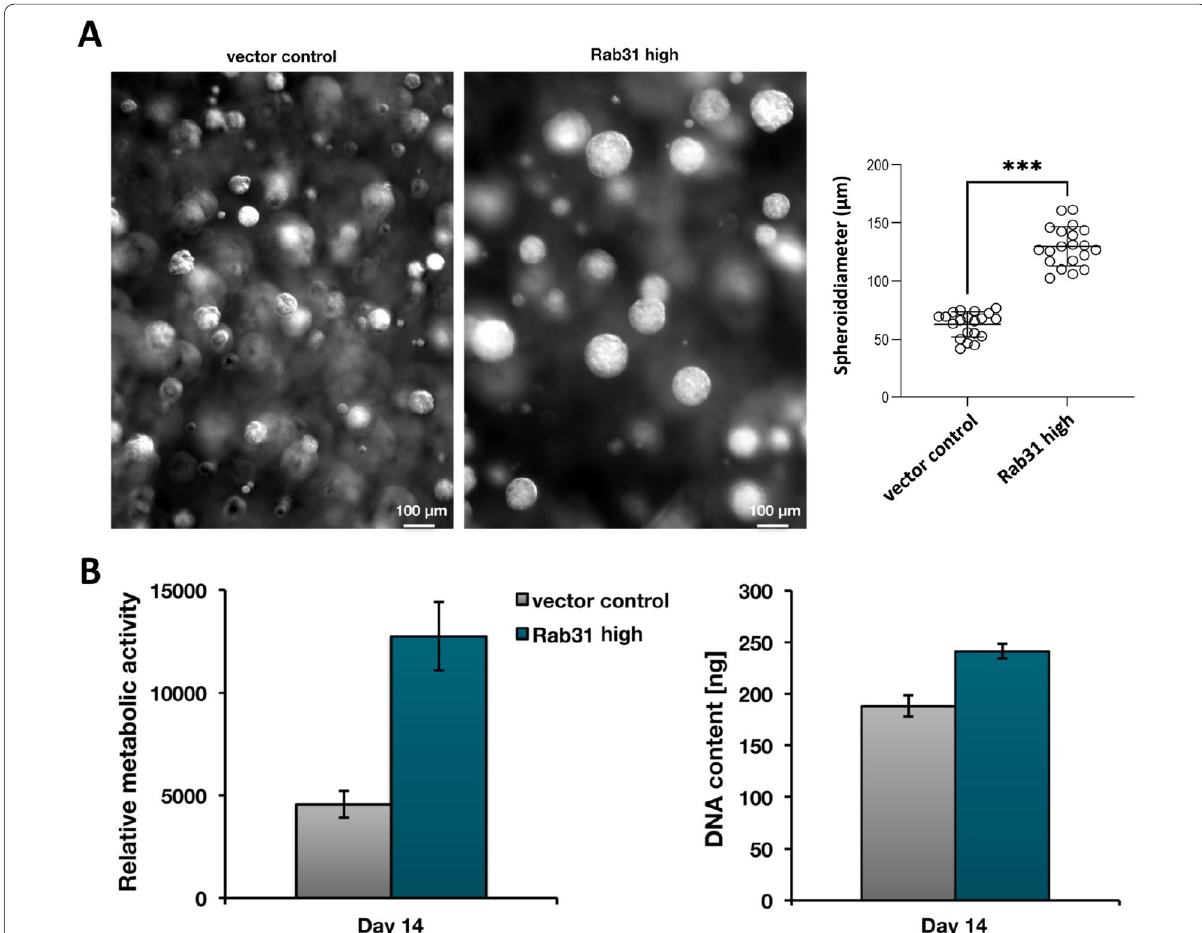
Fig. 2 Spheroid formation and proliferation analysis of CAMA-1 Rab31 overexpressing and vector control cells. A Both CAMA-1 Rab31 overexpressing and vector control cells formed spheroids in 3D culture, whereby Rab31 overexpressing cells resulted in much larger spheroids indicating a distinctly increased growth rate compared to vector control cells (p < 0.001). B Viable cells continuously convert the non-fluorescent substrate AlamarBlue into a fluorescent product (left panel), thereby allowing a quantitative measurement of cell numbers. Since the same cell number was plated out, Rab31 overexpressing cells display a faster growth rate as compared to vector control cells after 14 days. In the CyQuant assay (right panel), the content of DNA is measured by a non-fluorescent substrate, which upon intercalation into genomic DNA exhibits a